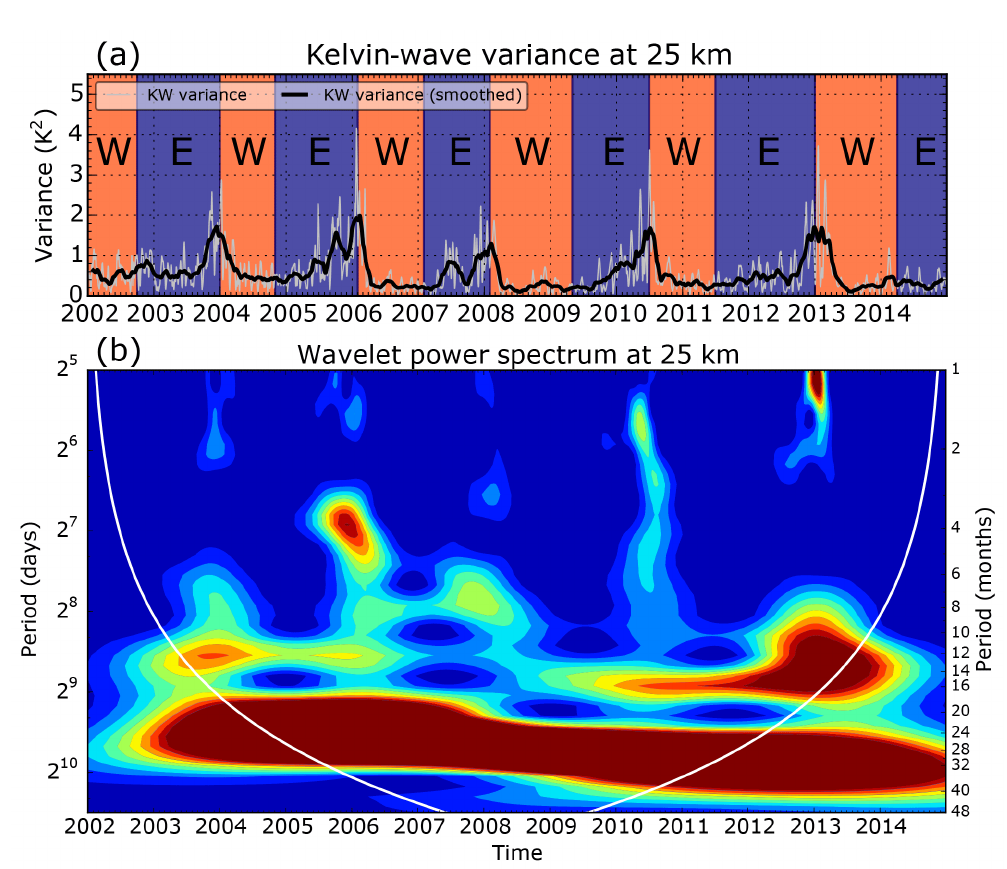
Figure 7. Time series of daily Kelvin-wave variance (thin gray) and smoothed Kelvin-wave variance (thick black) from January 2002 to December 2014 at an altitude of 25km (top panel). Orange and blue background colors indicate westerlies (W) and easterlies (E) at 25km above Singapore. Wavelet power spectrum of daily Kelvin-wave variance at 25km (bottom panel). The white line indicates the cone of influence. The period shown on the right y axis (period in months) is calculated assuming 30 days per